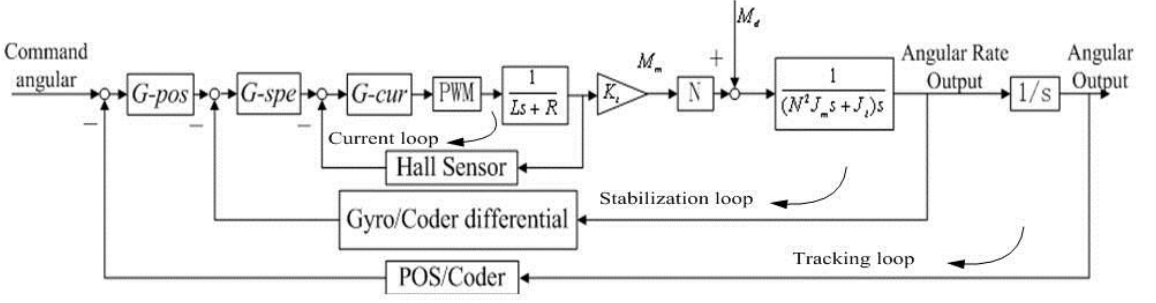
Figure 3. A block diagram of a traditional three-loop control system for an